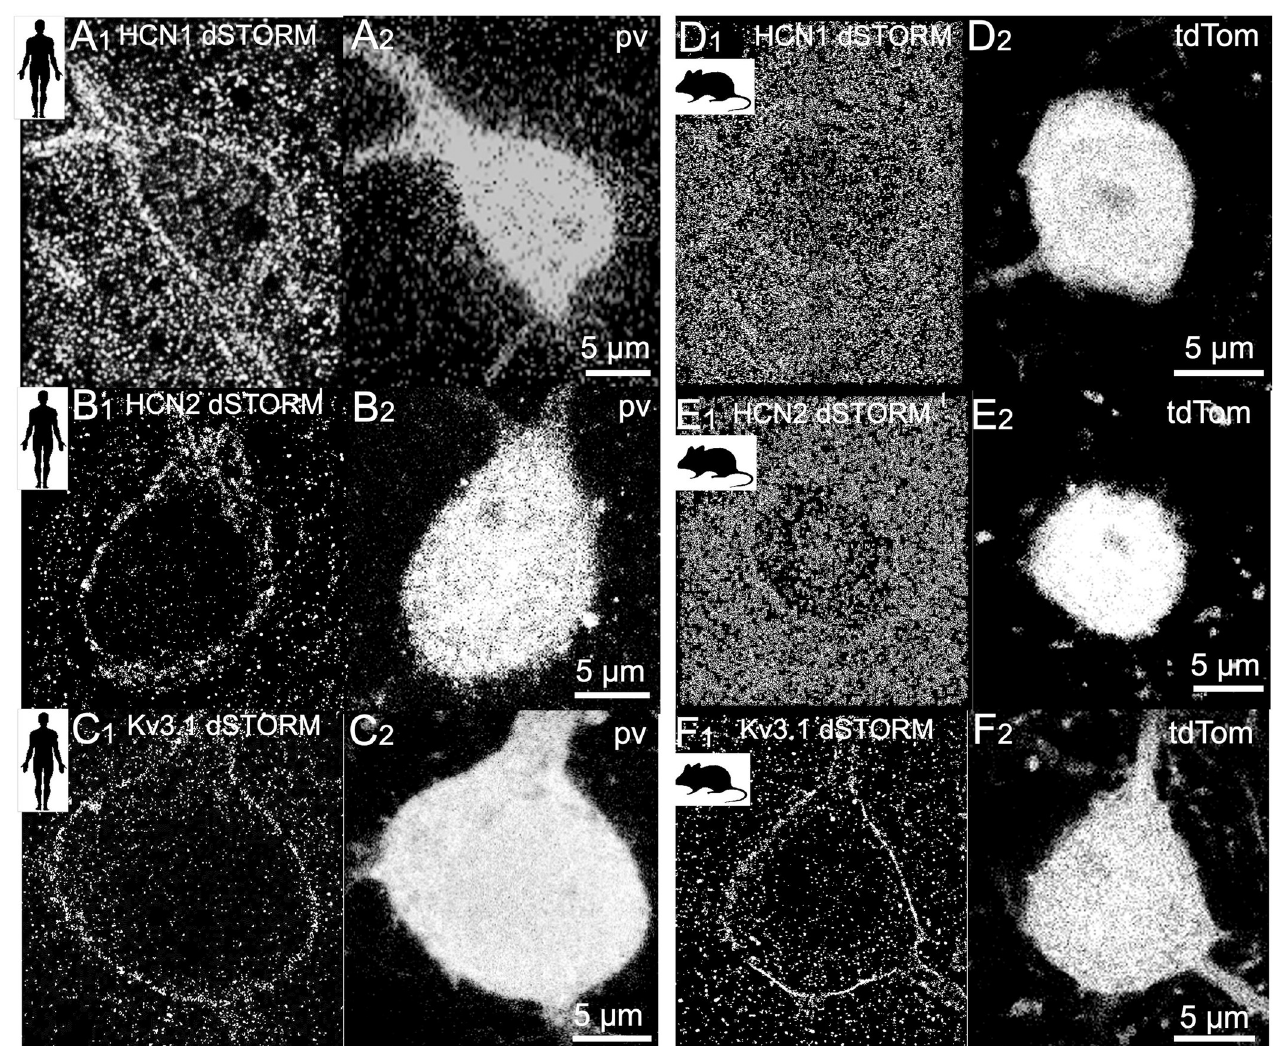
Fig 3. Visualization of somatic HCN1, HCN2, and Kv3.1 channels in human and mouse pv-immunopositive interneurons by dSTORM super-resolution immunofluorescence microscopy. ( A - C ) dSTORM super-resolution images showing high-resolution immunofluorescence labeling of HCN1, HCN2, and Kv3.1 channels in human pv-immunopositive cells. Pv immunoreactivity is shown in paired confocal images. ( A ) dSTORM image of HCN1 immunolabeling ( A1 ) using Alexa 647 as the fluorophore paired with a confocal image of pv immunoreactivity ( A2 ) using Cy3 as the fluorophore. HCN1 immunoreactivity is concentrated at apparent membrane zone around the cell soma and proximal dendrites. ( B ) dSTORM image of HCN2 immunolabeling ( B1 ) using Alexa 647 as the fluorophore paired with a confocal image of pv immunoreactivity ( B2 ) using Cy3 as the fluorophore. Strongest HCN2 immunofluorescence is localized at the apparent cell soma membrane zone. ( C ) dSTORM image of Kv3.1 potassium channel immunostaining using CF568 as the fluorophore ( C1 ) paired with a confocal image of pv immunoreactivity ( C2 ) using Alexa 488 as the fluorophore. Kv3.1 immunoreactivity is concentrated at the apparent membrane zone. ( D - E ) Mouse pv cell showing weak or absent HCN1 or HCN2 immunofluorescence at the cell soma membrane. dSTORM images of HCN1 ( D1 ) and HCN2 ( E1 ) immunoreactivity using Alexa 647 as the fluorophore are paired with confocal images of pv-associated fluorescence (tdTomato) (D2 and E2, respectively). ( F ) dSTORM image of Kv3.1 immunolabeling ( F1 ) using Alexa 647 as the fluorophore paired with a confocal image of pv-associated intracellular fluorescence signal ( F2 ). Kv3.1 immunofluorescence is localized around the cell soma.